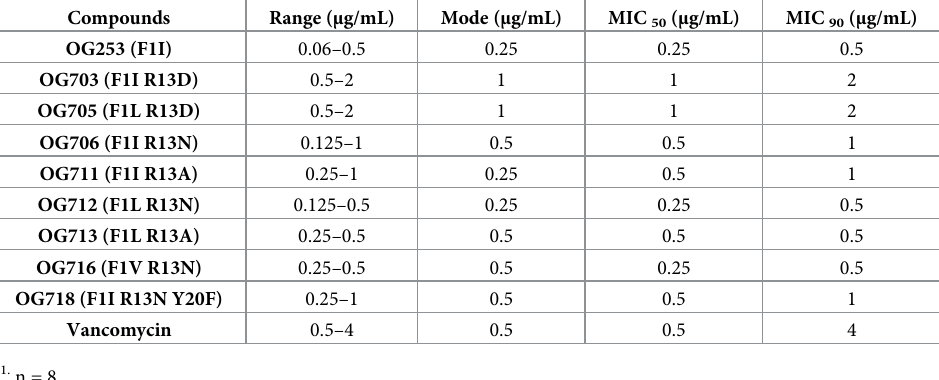
Table 3. MIC characteristics of selected compounds against C . difficile 1